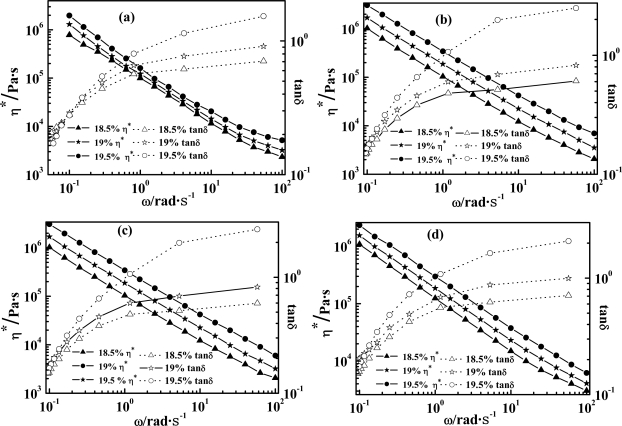
Rheological curves dependences of PPTA-H2SO4 LC solution on shearing frequency (ω), PPTA wt% at 18.5, 19 and 19.5%, and temperatures of (a) 75 °C, (b) 80 °C, (c) 85 °C and (d) 90 °C.